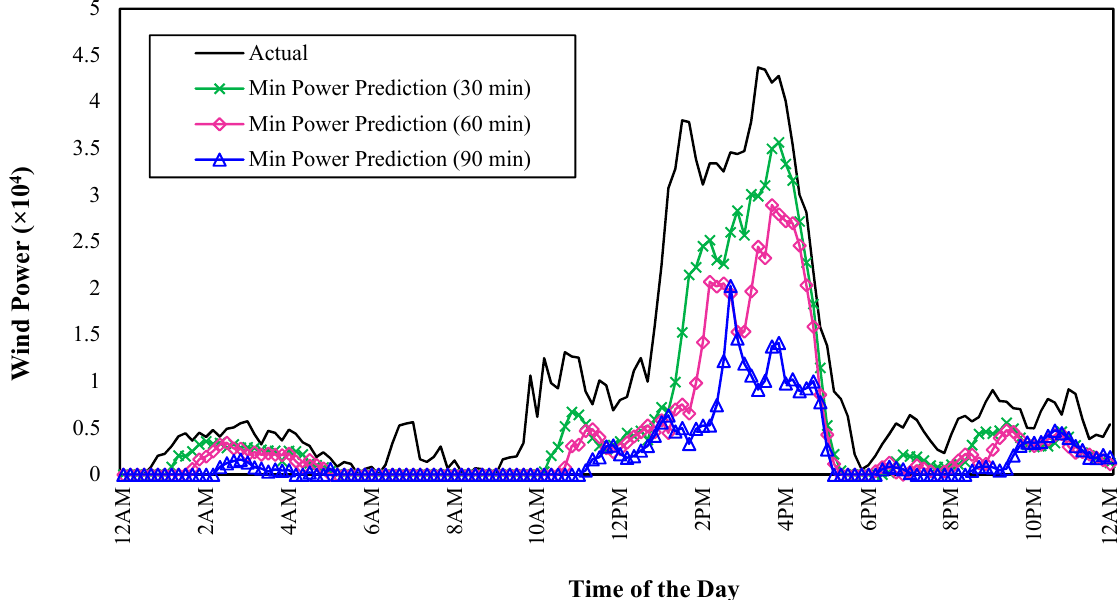
Figure 12. A sample of the lower bounds for the power generation estimates compared with the deterministic estimates and actual measurements, at different time horizon (i.e., 10, 30, 60, and 90 min).